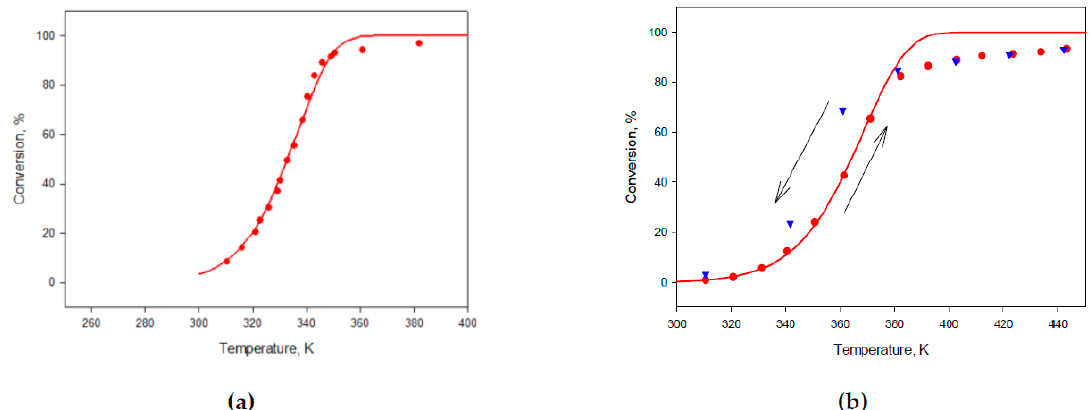
Figure 3. ( a ) The temperature dependence conversion in the oxidation of CO on the catalyst. CeO 2 /ZrO 2 + 4 wt.% Pd. The initial concentration of CO is 2270 ppm, the O 2 concentration is 15% in N 2 ; ( b ) The temperature dependence conversion in the oxidation of CO on the catalyst CeO 2 /ZrO 2 + 4 wt.% Pd. The initial concentration of CO is 8250 ppm, the O 2 concentration is 2% in N 2